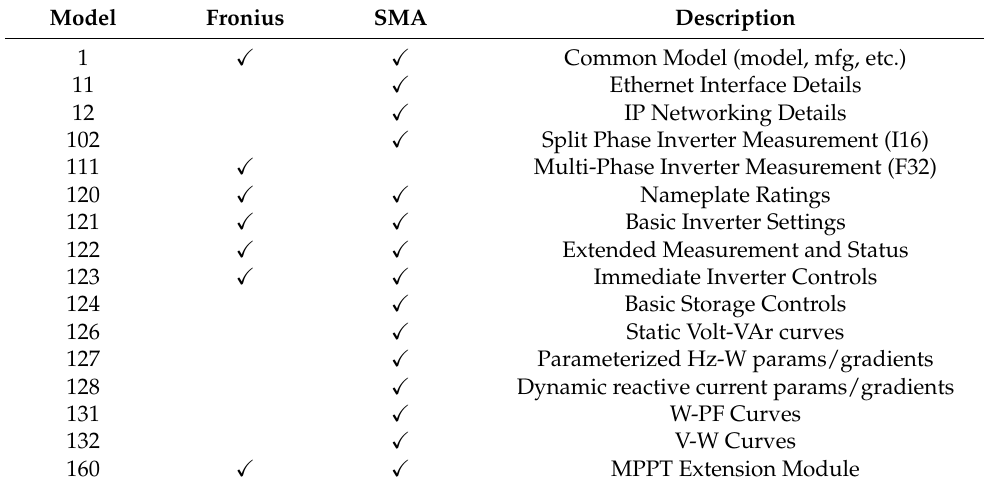
Table 1. SunSpec models leverage for the implementation, with their applicability to the inverters and description.